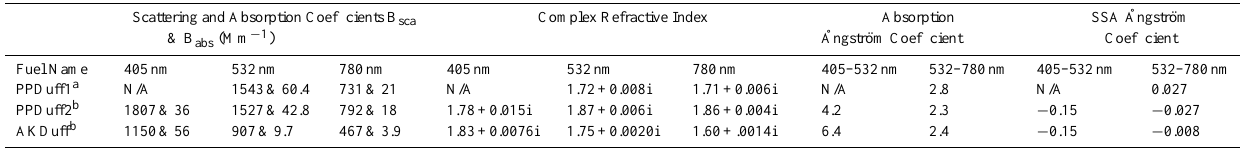
Table 1. Summary of the experimentally determined optical properties of tar balls emitted from the combustion of two fuels: Ponderosa Pine Duff (PPDuff, at two sampling times) and Alaskan Duff (AKDuff).